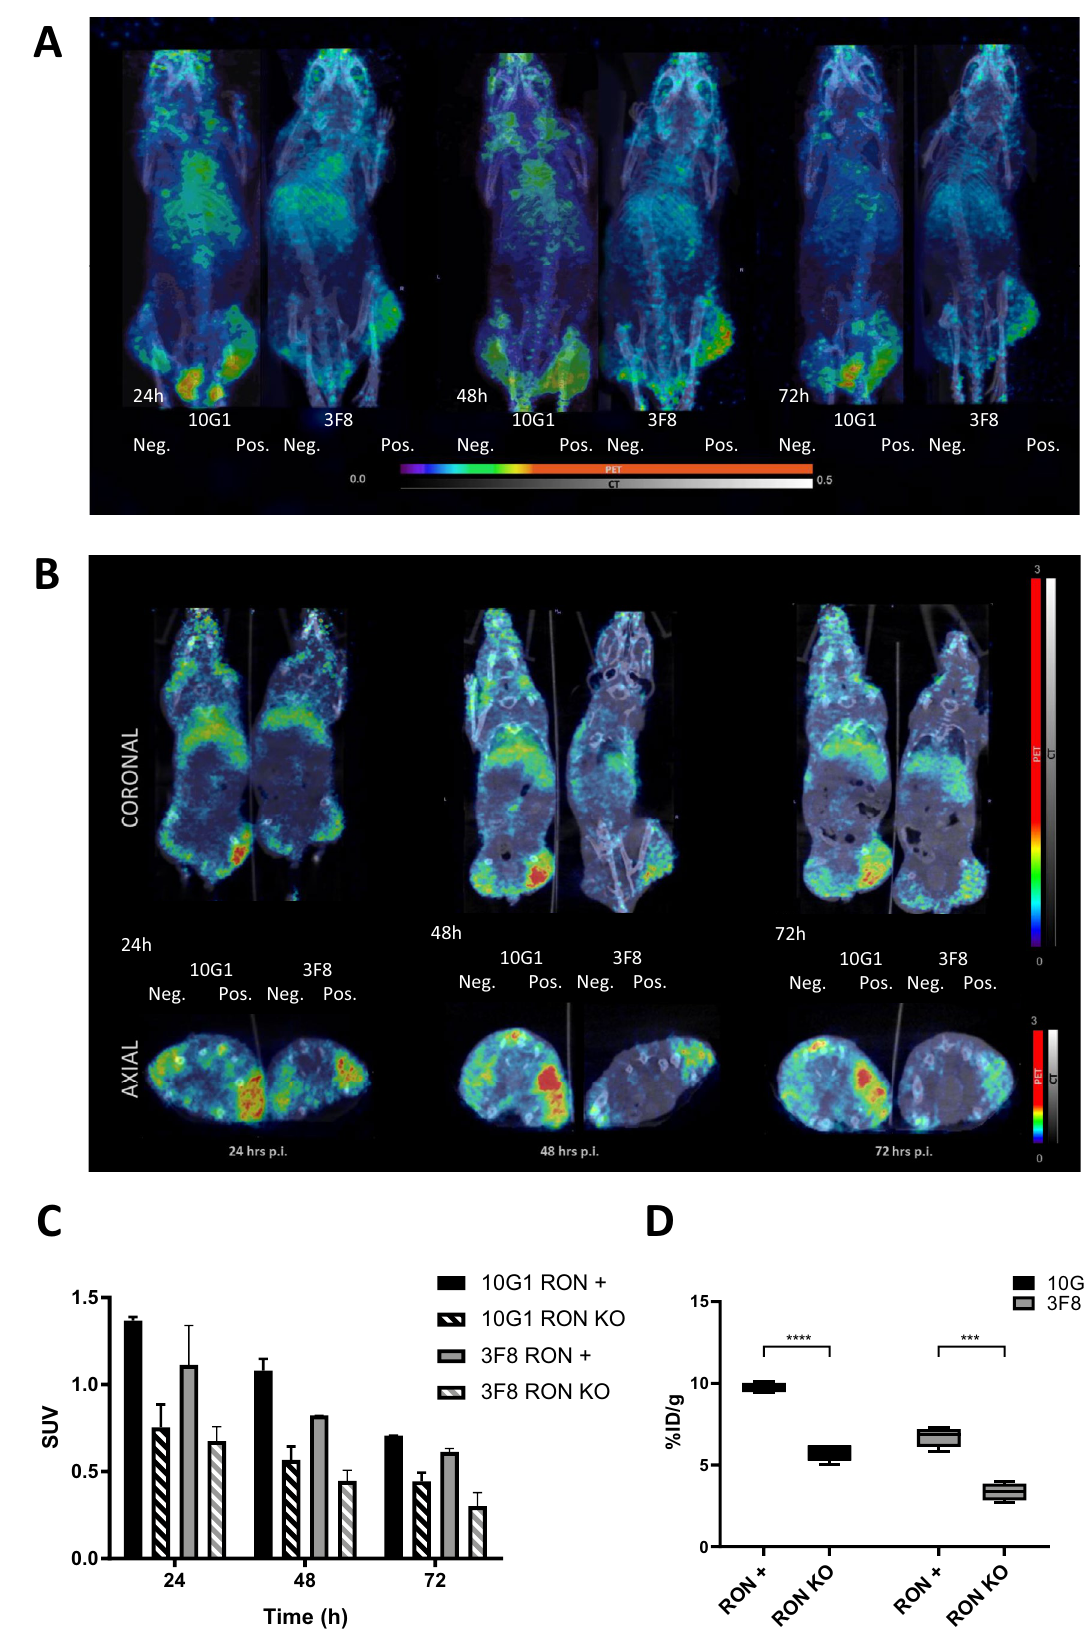
Figure 5. RON antibodies selectively target RON-positive HT29